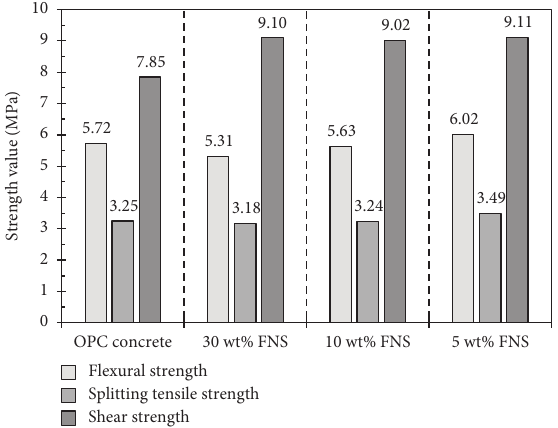
Figure 5: Strength characteristics of FNS concrete at flexural, splitting tensile, and shear strengths